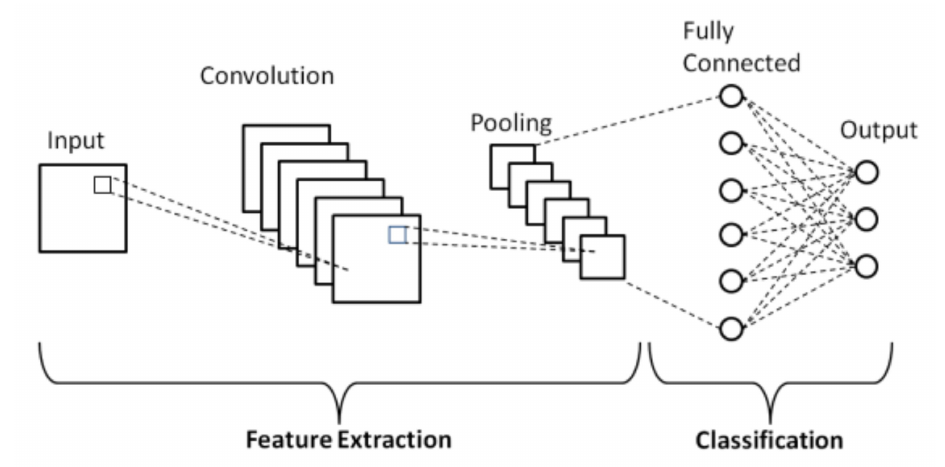
Figure 3. Convolutional Neural Network (CNN) Architecture